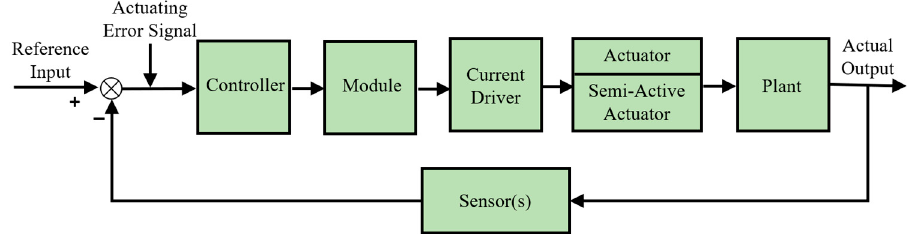
Figure 1. Block diagram of a typical control system featuring MR actuator devices [18]. Reproduced with permission from Choi, S.-B. and Han, Y.-M., Magnetorheological Fluid Technology: Applications in Vehicle Systems; published by CRC Press, 2013.